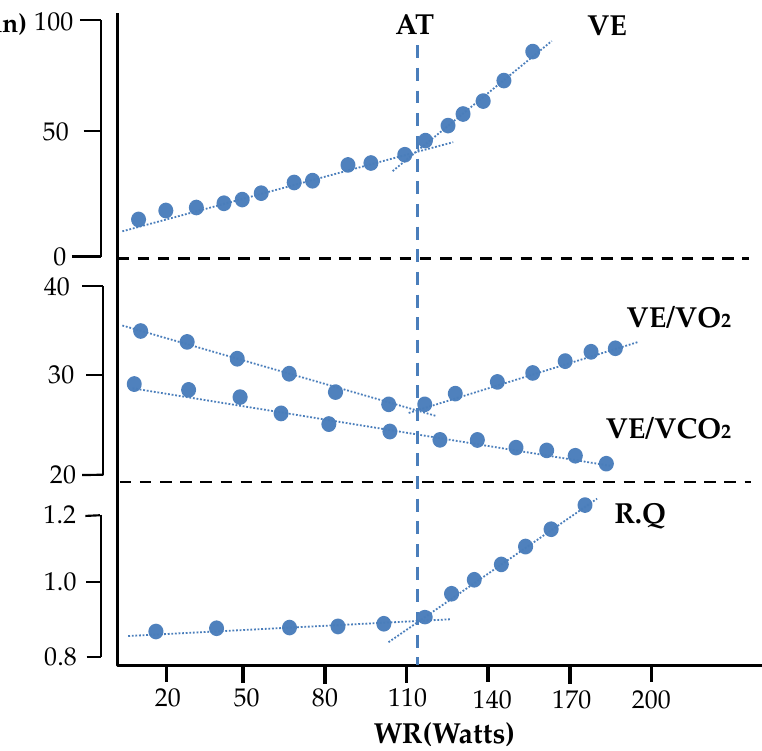
Figure 2. The AT is defined based on each ventilation index. Figure 2 was created by partially reorganizing the subject data.